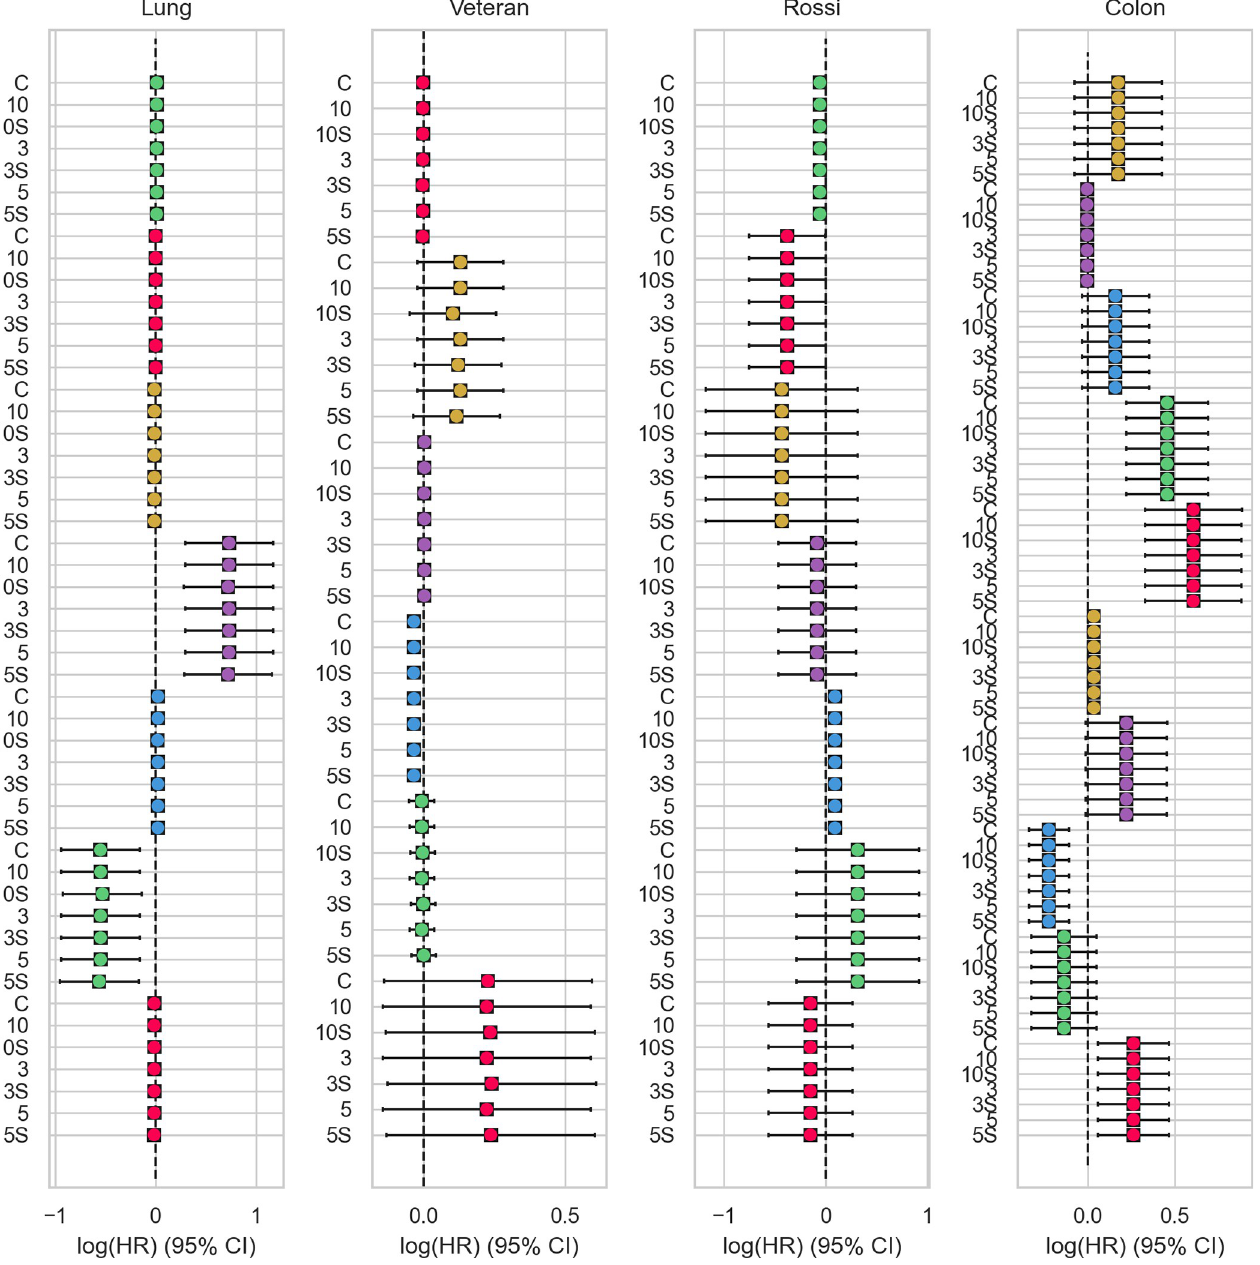
Fig 4. Evaluation of the Cox proportional hazards model on benchmark datasets. For each dataset, we compared the logarithmized hazard ratio and corresponding 95% CI of our algorithms for 3, 5, and 10 clients with the results of the centralized lifelines model. For all covariates (distinguished by colors), the federated-only (3, 5, 10) and hybrid approach (S3, S5, S10) resulted in almost identical results compared to the centralized calculation using lifelines